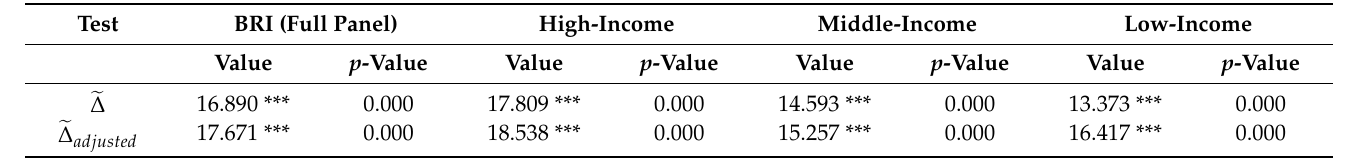
Table 2. Results of slope homogeneity test in BRI economies.